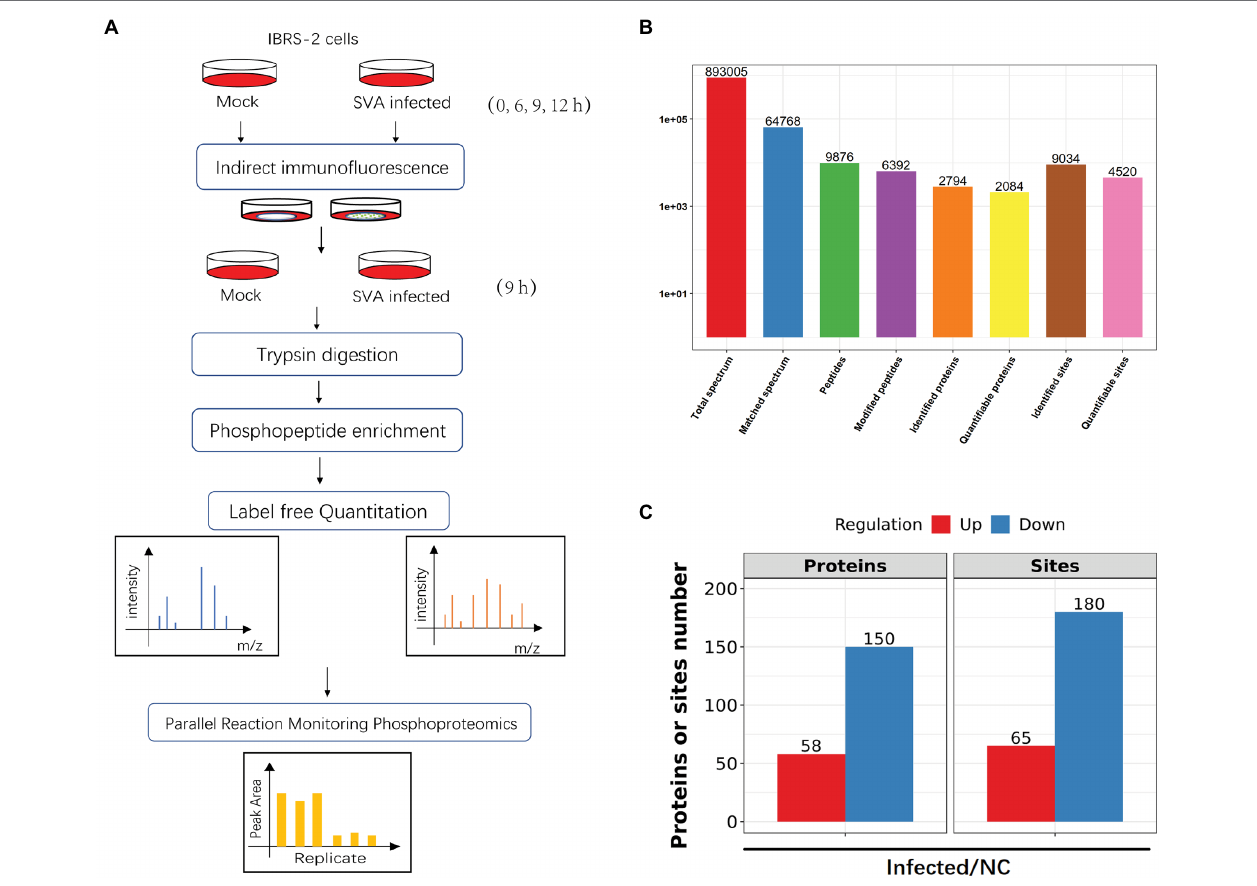
FIGURE 2 | A quantitative overview of the phosphoproteomic analysis of phosphoproteins with differentially regulated phosphosites. (A) Schematic workflow of phosphoproteomic analysis of IBRS-2 cells infected with SVA. (B) Overview of phosphoproteomics analysis, including identifying and quantifying phosphoproteins and phosphopeptides. (C) The significant change proteins after SVA infection upon proteomics analysis; the number of phosphoproteins and phosphosites based on a ratio of infected vs. non-infected control (NC) groups >1.5 ( p < 0.05) for the upregulated threshold and <1.5 ( p < 0.05) for the downregulated